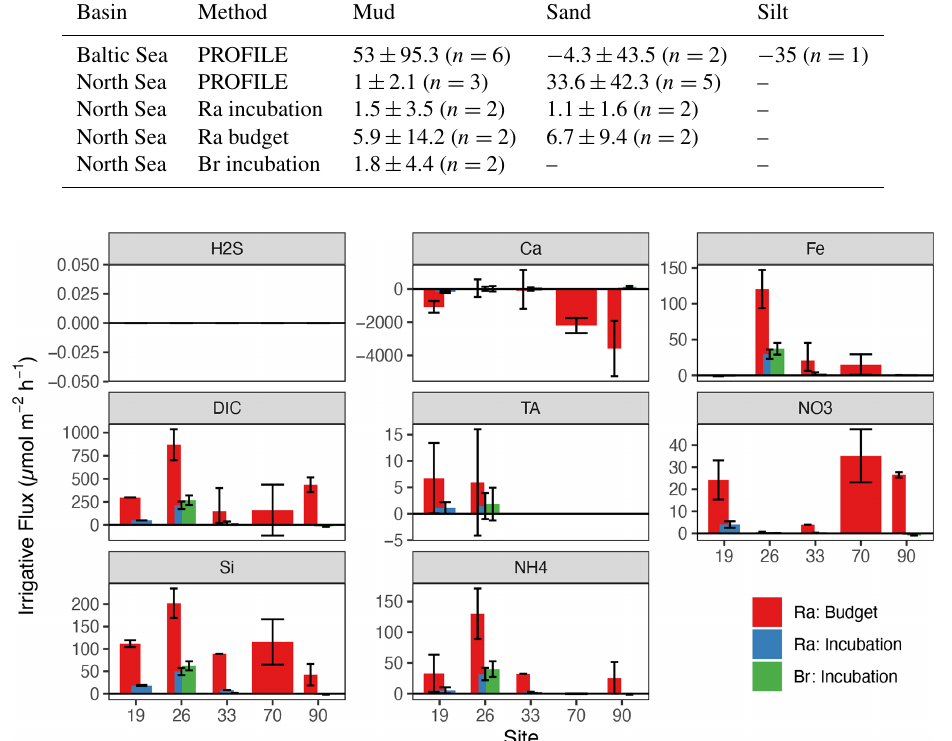
Figure 3. Average sediment–water fluxes (µmolm − 2 h − 1 ) derived from Ra or Br − incubation or Ra decay from the North Sea sites only. In this figure, the error bars represent minimum and maximum fluxes calculated from replicate porewater cores taken at each